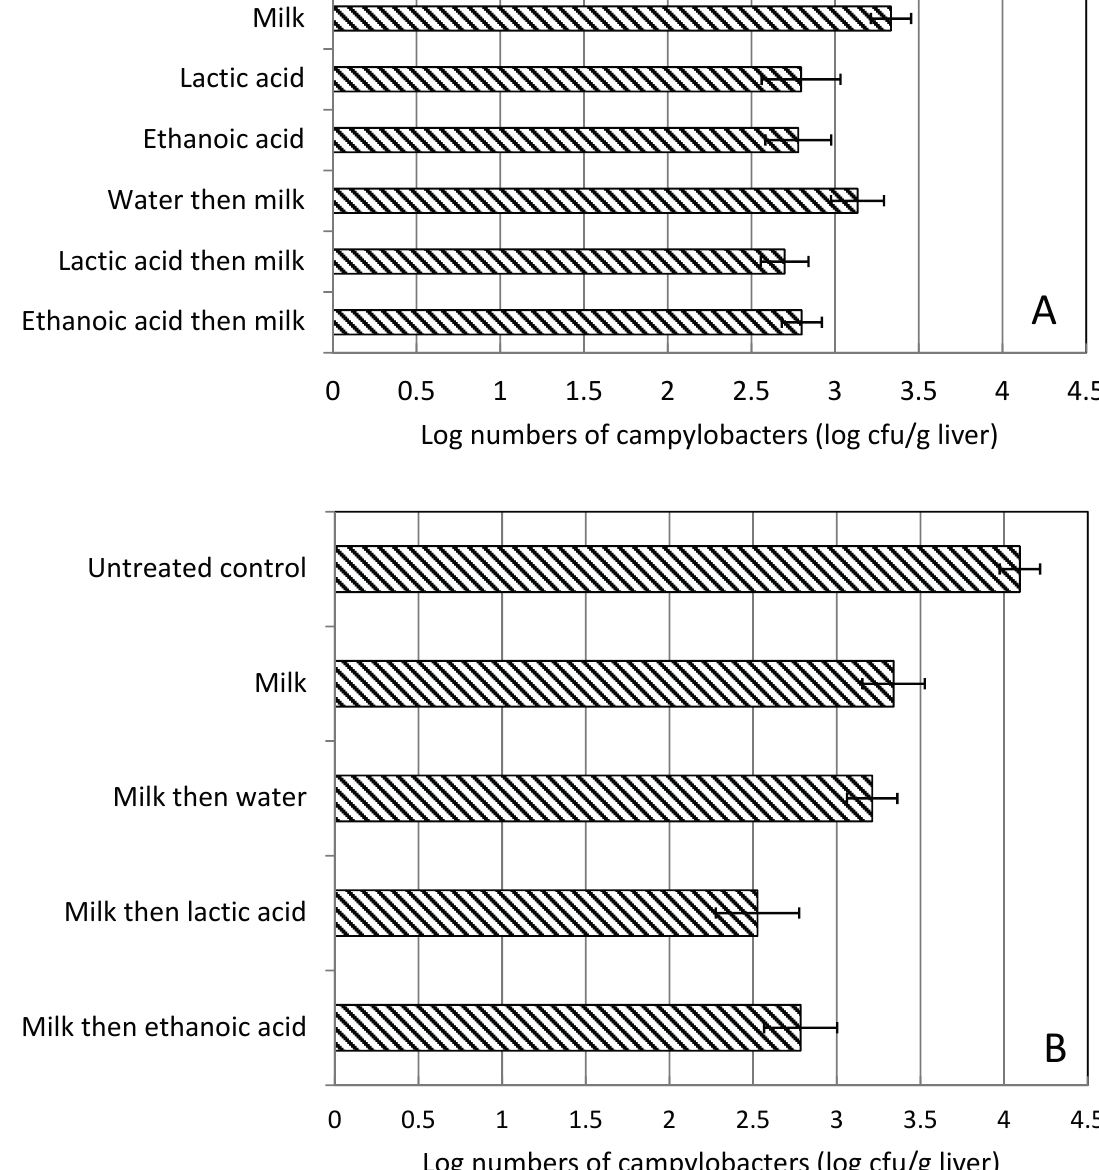
Figure 3. ( A ) The effect of immersing livers in water or organic acid (2 min for each solvent), milk (for 1 h) or organic acid immersion (2 min) followed by milk immersion (1 h) on the numbers of campylobacters present on chicken livers. ( B ) The effect of immersing livers in milk (for 1 h) followed by immersion in water or organic acid (2 min for each solvent) on the numbers of campylobacters present on chicken livers. For both experiments, final clearance livers were stored chilled at 2 °C for 48 h before the commencement of each treatment. Error bars are the standard error of the mean log count for both